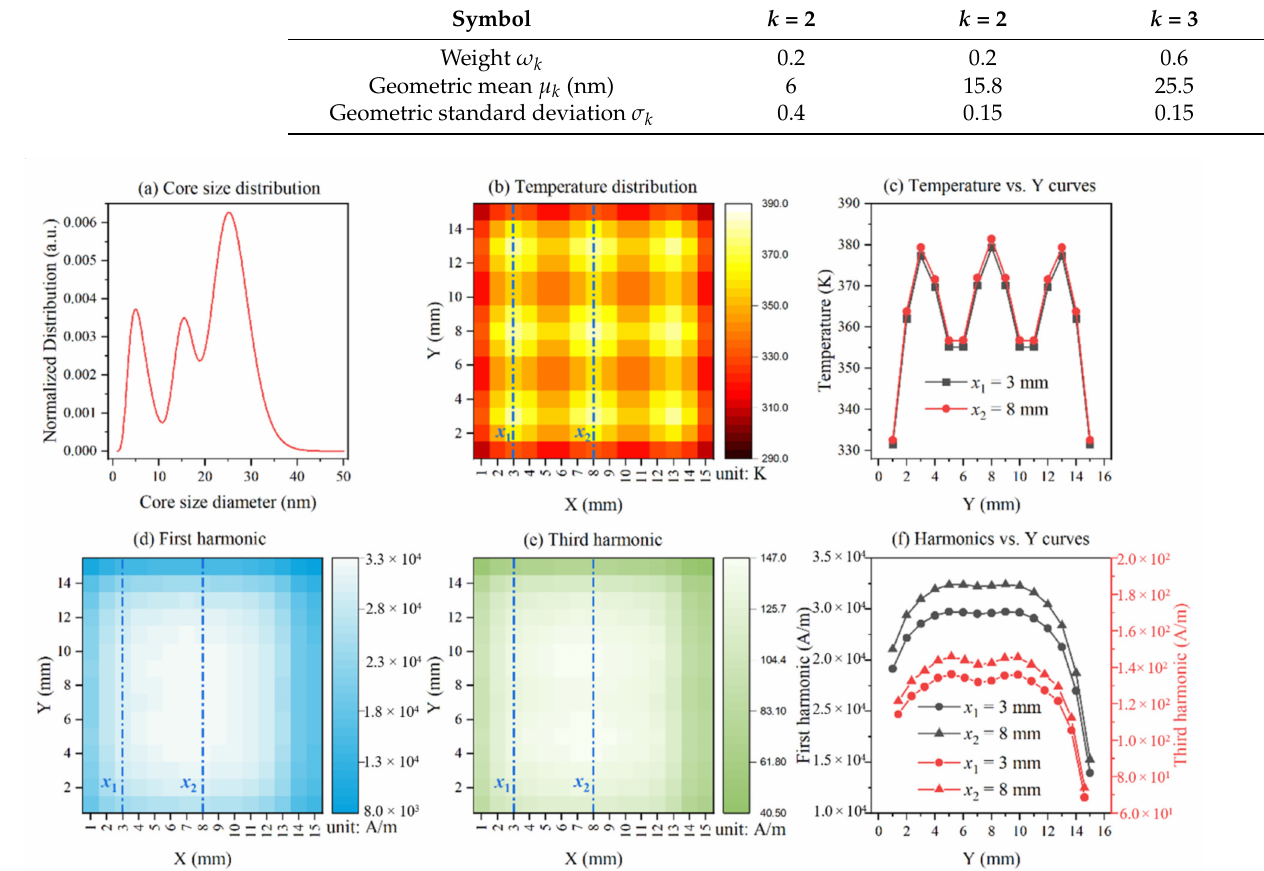
Figure 2. ( a ) The hypothetical core size distribution of MNPs. ( b ) The temperature distribution of 2-D imaging area coated with MNPs. The entire 2-D imaging area is 15 mm × 15 mm, with the resolution of 15 px × 15 px. ( c ) The temperature versus Y curves along the white dashed lines ( x 1 = 3 mm and x 2 = 8 mm). ( d ) First harmonic distribution of magnetic nanoparticles on each pixel point after scanning. ( e ) Third harmonic distribution of magnetic nanoparticles on each pixel point after scanning. ( f ) The harmonics versus Y curves along the white dashed lines ( x 1 = 3 mm and x 2 = 8